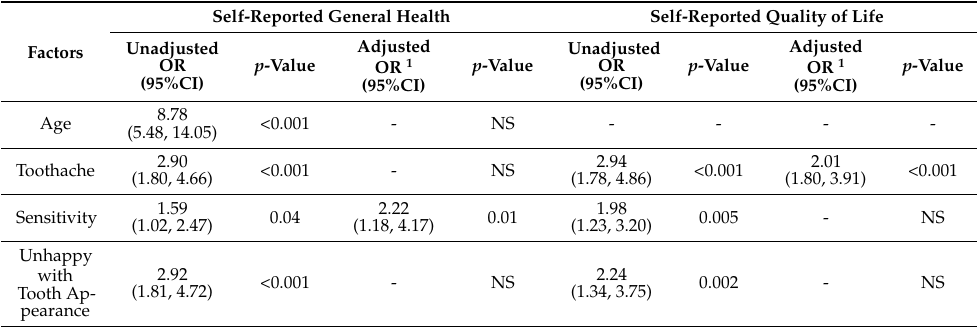
Table 5. Multiple logistic regression reporting the most important predictor for fair/poor general health and fair/poor quality of